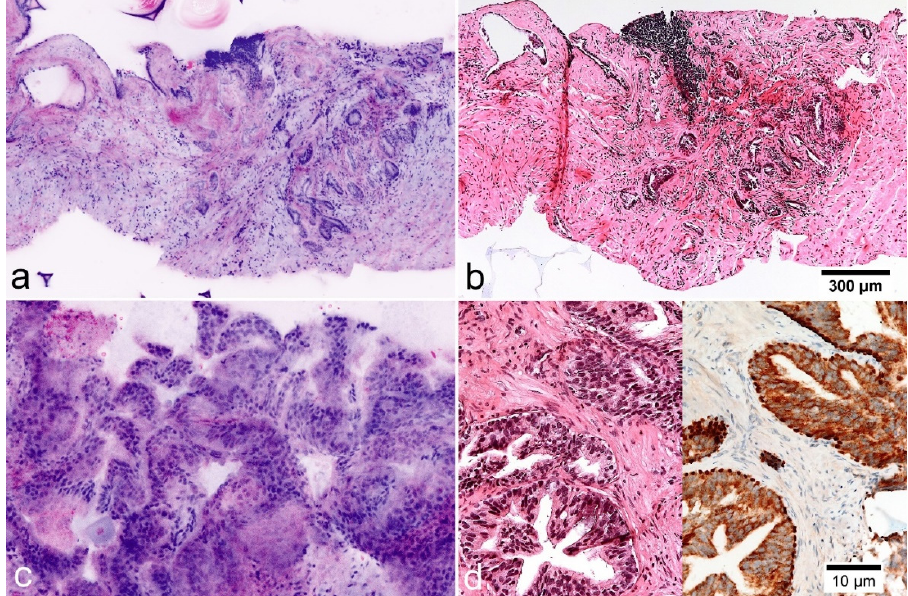
Figure 4. Mimickers of prostate carcinoma in FCM images (left) and FFPE morphology. ( a , b ) Posta- trophic hyperplasia. Clusters of small glands with hyperplastic stroma and chronic inflammation. The basal cell layer is not visible in the images. ( c , d ) High-grade prostatic intraepithelial neoplasia (HgPIN). Organoid glands lined out by atypical epithelium with enlarged nuclei and prominent nucleoli. Immunostaining for P504S shows cytoplasmatic expression in the luminal cells. p40 shows preserved basal